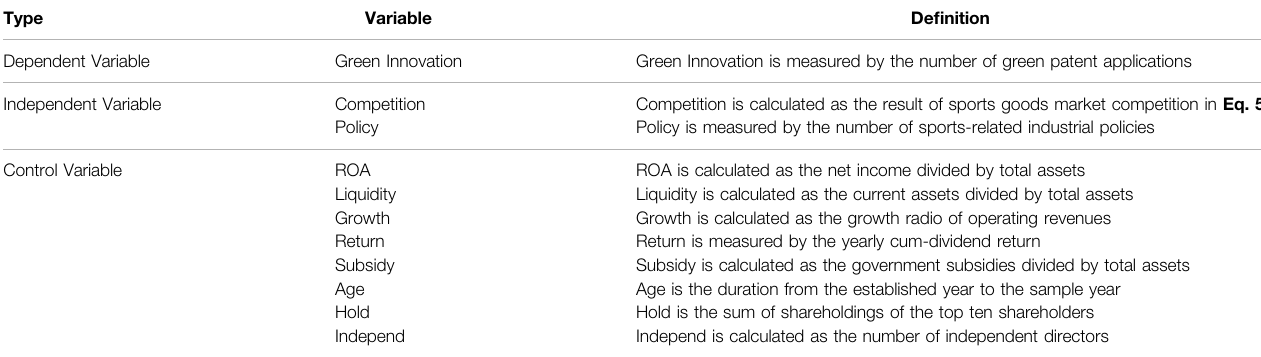
TABLE 1 | The de fi nition of variables. Type Variable De fi nition Dependent Variable Green